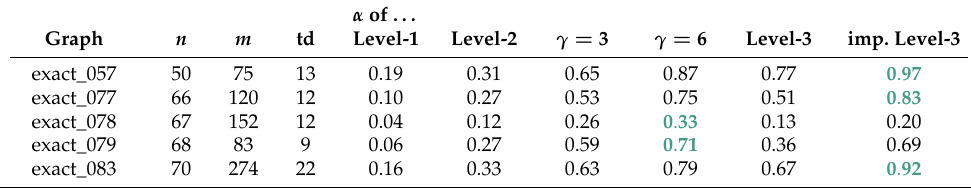
Table 6. Same as Table 4, but on instances from the PACE 2020 benchmark set [45].